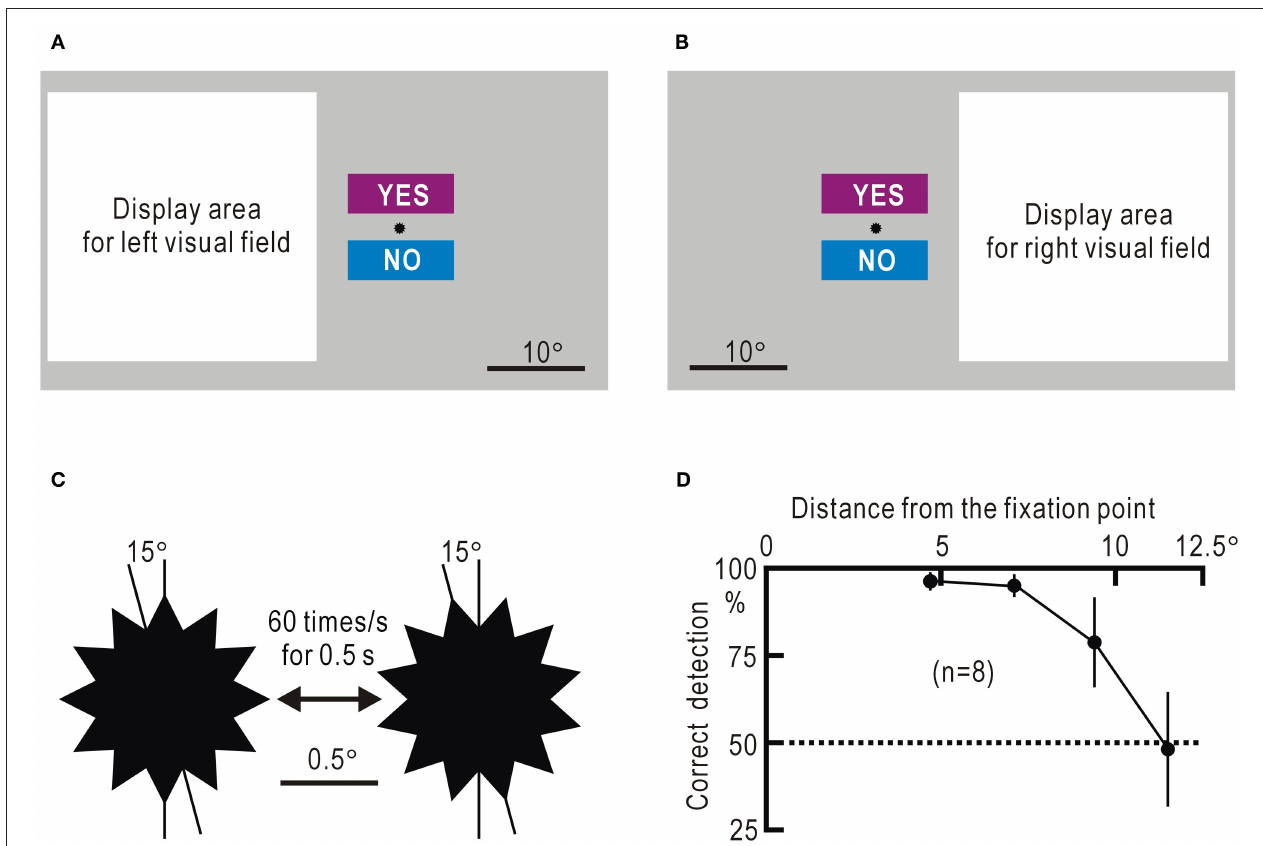
FIGURE 1 | (A) Screen image used to test the left visual field. The white square represents the display area in which various stimuli are presented. The small star is placed at the fixation point. The rectangles labeled “YES” and “NO” are areas to which the participant responds by touching or clicking with a mouse. (B) Screen image used to test the right visual field. (C) Enlarged view of the dodecagonal star at the fixation point. The star rotationally vibrates for 0.5s at a speed of 60 times/s with an angle of 15 ◦ . (D) Percentage of correct detection of the remote star vibration plotted against the distance between the object and the fixation point. The mean ± SEM of the eight visual fields in four control participants is